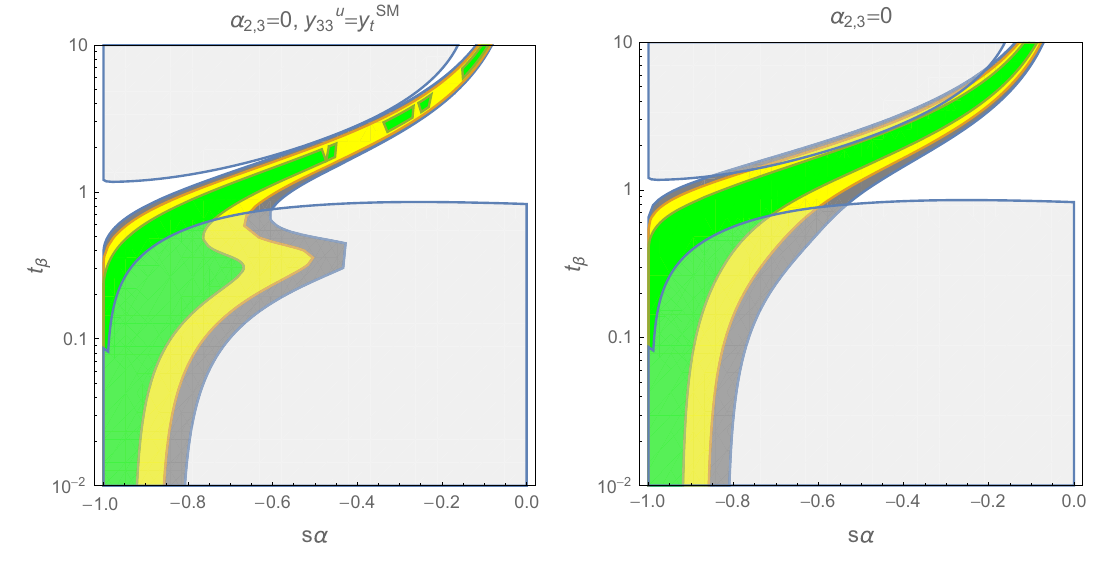
= m = 450 GeV, h 2 H ±